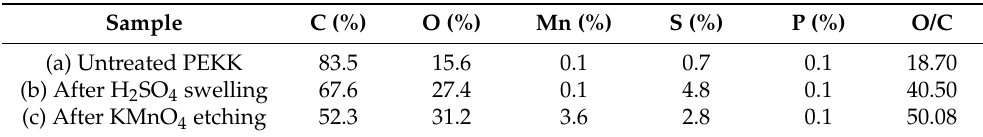
Table 2. Surface composition and the ratio of carbon–oxygen contents: (a) Untreated PEKK; (b) After H 2 SO 4 swelling; (c) After KMnO 4